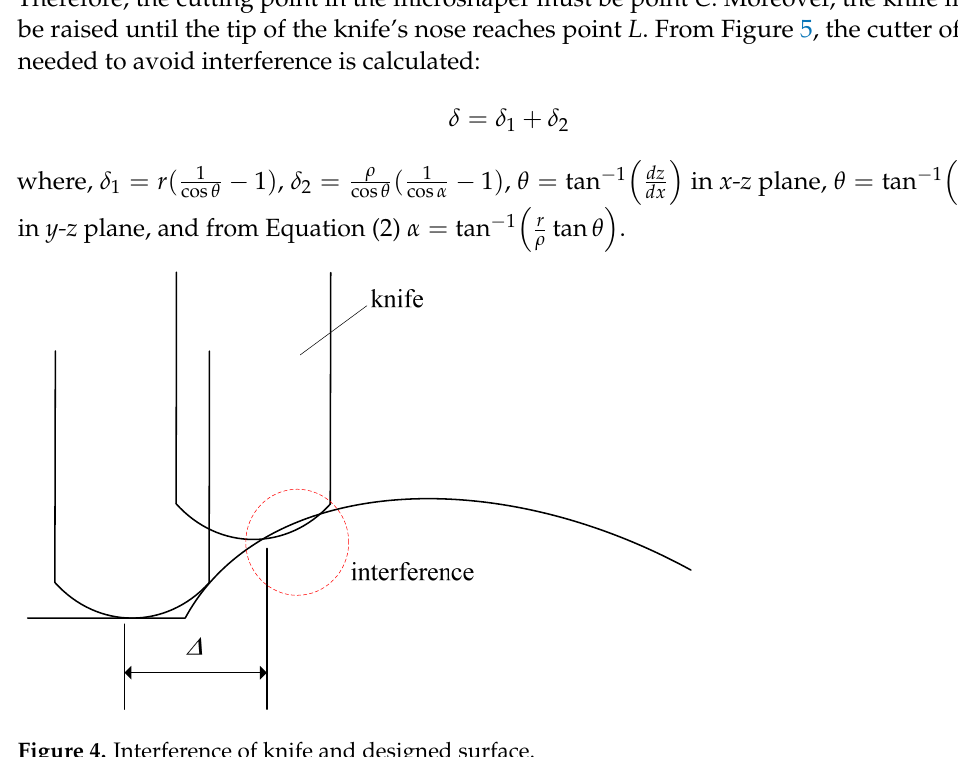
Figure 5. Geometry compensation of surface profile using cutter offsetting. Interference is not only happening in the profile of the curved surface ( x-z and y-z plane) but also in the boundary of the surface ( x-y plane). As shown in Figure 6, if the designed boundary of the curved surface is a circle with radius R 0 (black curve in the figure), the cutter path needs offsetting to compensate for the cutter interference. There- fore, the practical boundary must become the boundary with cutter offsetting (the red curve in this figure). As shown in Figure 6, the compensation of path direction ( x -direc- tion) δ x,i is: dxdz x ix